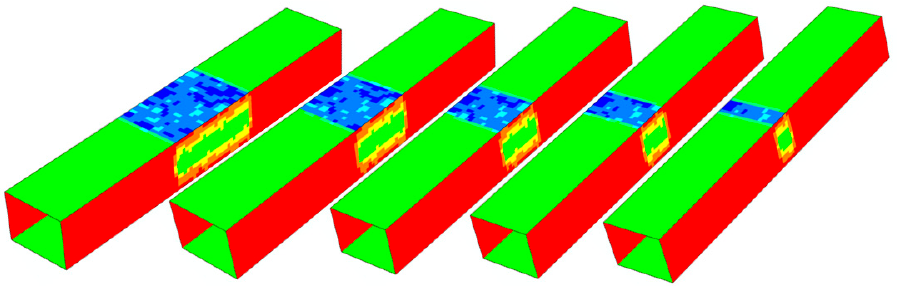
Figure 13. Model view illustrating the segment length effect investigations. Shell element thickness maps are shown.